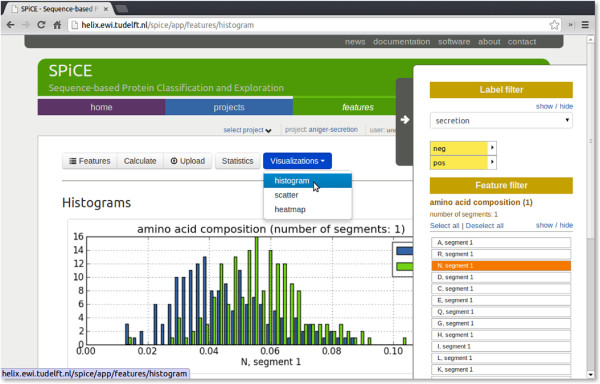
SPiCE screenshot.